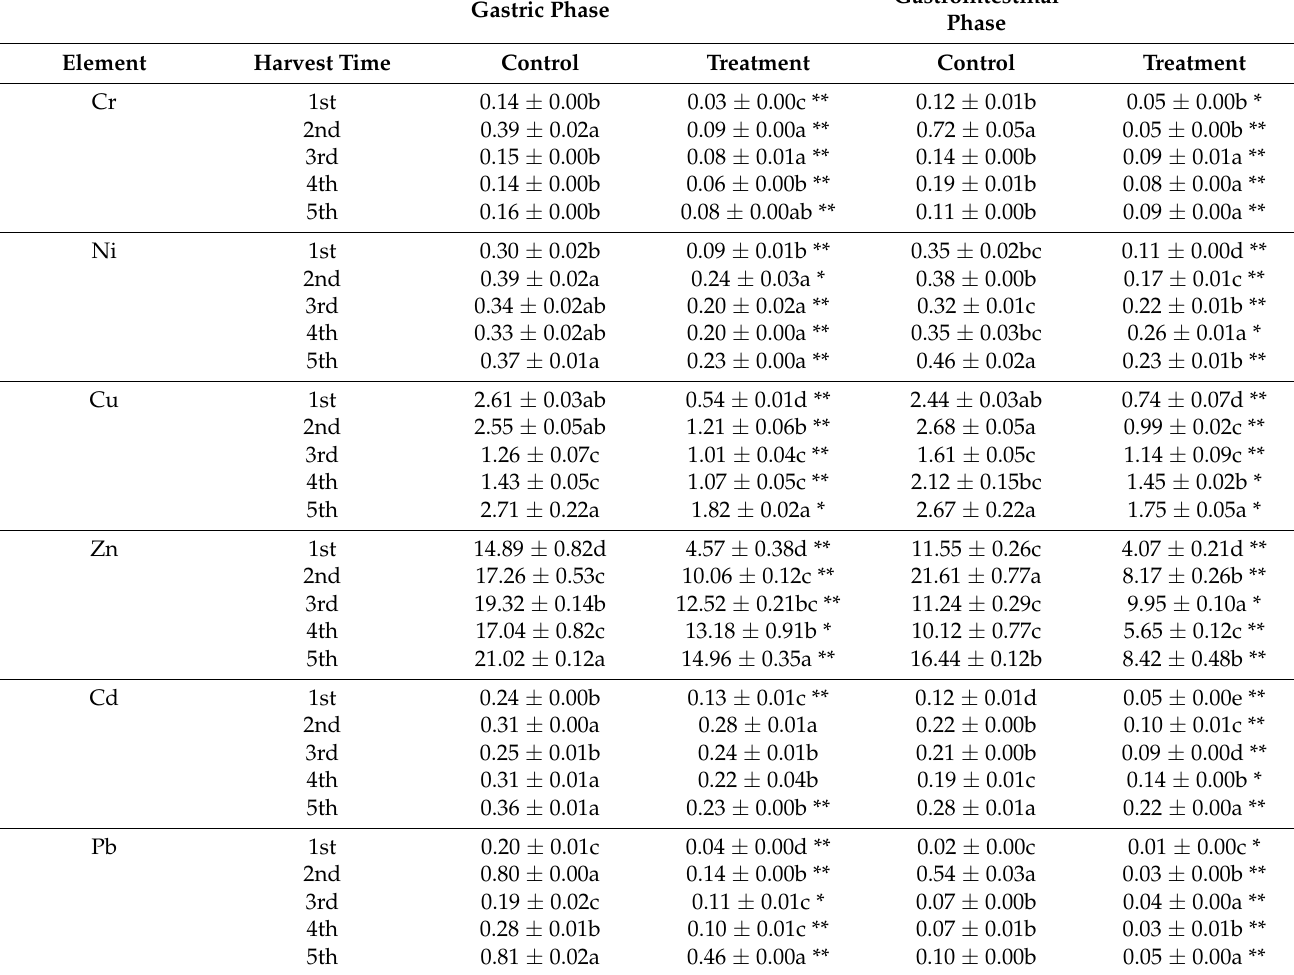
Table 3. Concentration (mg/kg on a fresh weight basis) of bioaccessible heavy metals in the edible portion of Gynura cusimbua . Gastric Phase